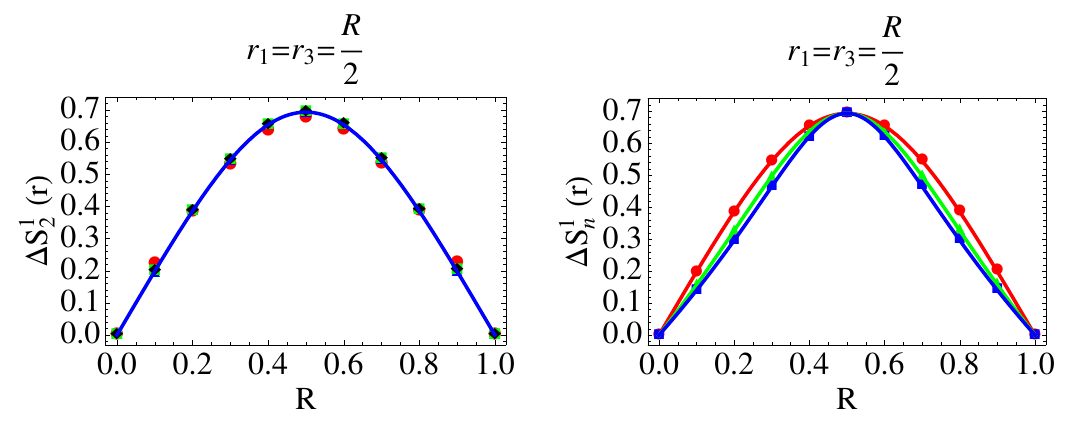
Figure 5 . Left: Numerical values of the 2nd R(cid:19)enyi entropy for r 1 (cid:16) r 3 (cid:16) R r (cid:16) 1 (cid:1) R and a single excitation. These are given for four di(cid:11)erent choices of the momentum of the excitation: p (cid:16) 0 (circles), p (cid:16) (cid:25) (triangles) and p (cid:16) 2 (cid:25) (squares) and 4 (cid:25) (rombi). Right: Numerical values of the 2nd (circles), 3rd (triangles) and 4th (squares) R(cid:19)enyi entropies for p (cid:16) 4 (cid:25) (single excitation) compared to analytic formula (continuous